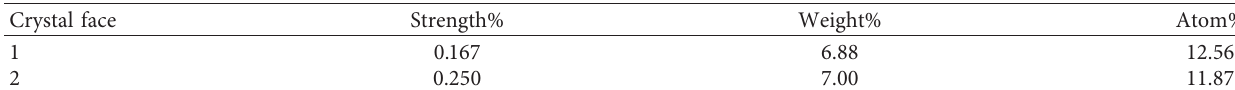
Figure 14: SEM photo of succinic acid at 0.02% and 1.5h at 100 ° C. Table 2: EDS of two points in SEM photo